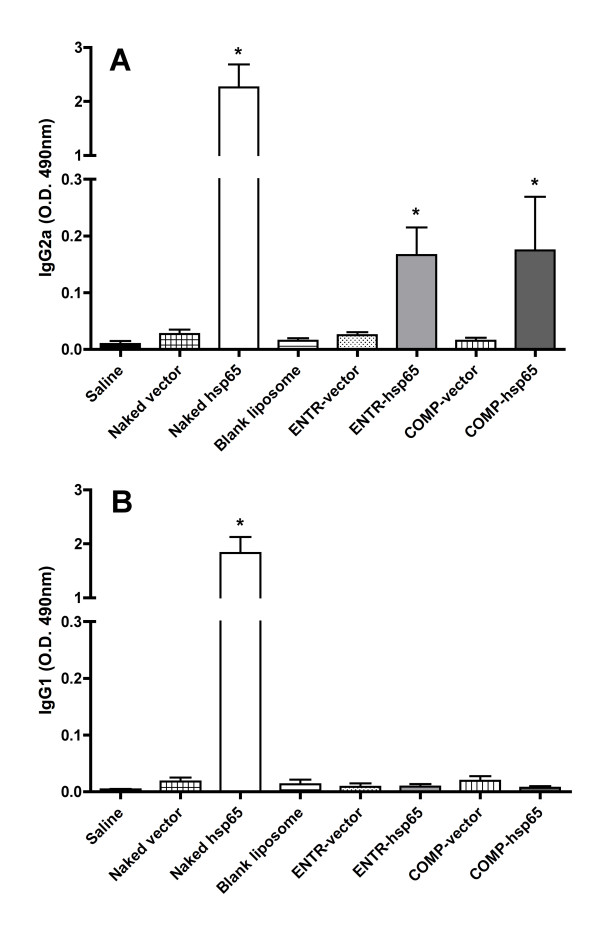
Anti-hsp65 subtype antibody production in mice immunized with liposomes or naked DNA. BALB/c mice were immunized by intramuscular injection with 4 doses of 100 μg of naked DNA or a single dose of 100 μL of liposome (corresponding to 50 μg of DNA). Anti-hsp65 antibody levels were evaluated in mice serum by ELISA 30 days after the last immunization. A) IgG2a and B) IgG1 isotypes. Results are presented by mean ± SD of optical density. *p < 0.05 were considered significant when compared to saline group or their respective controls.